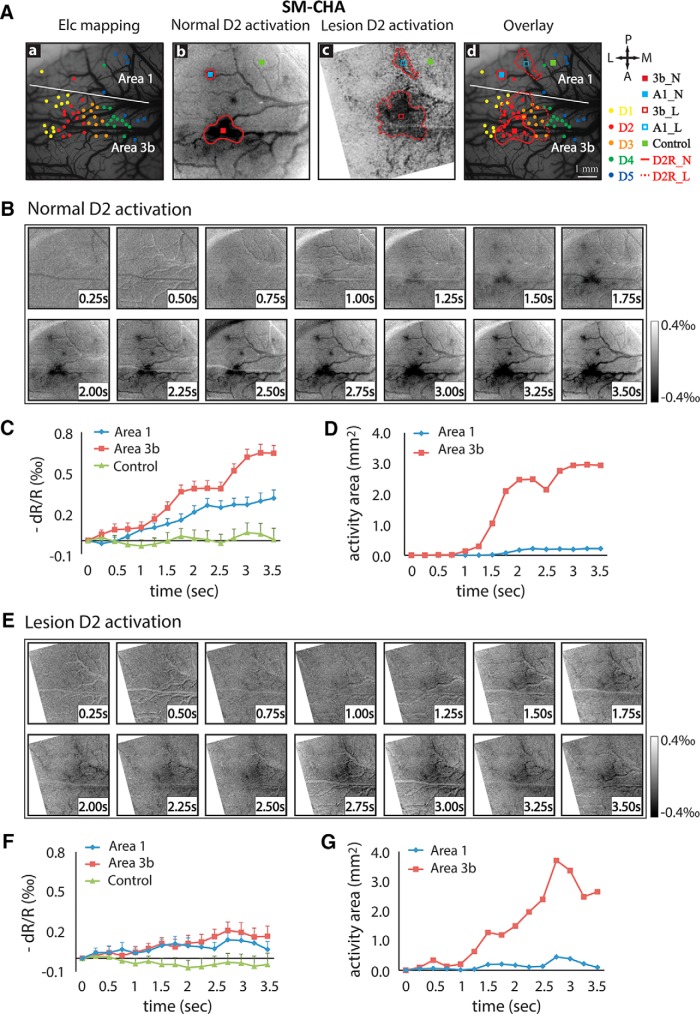
Spatiotemporal dynamics of optical imaging activation in response to single-digit stimulation in somatosensory areas 3b and 1 before and after a DCL in one representative monkey (SM-CHA). Aa–Ad, Postlesion electrophysiological map of digit representation (Aa), D2 mean activation map before DCL (Ab), D2 mean activation map after DCL (Ac), and overlay of Aa, Ab, and Ac (Ad). Electrode penetration sites and properties of the receptive fields are indicated by color dots, and the digit activations are circled by color outlines. Receptive field properties: yellow dots, D1; magenta dots, D2; orange dots, D3; green dots, D4; and blue dots, D5. Full red outlines (D2R_N) and dash red outlines (D2R_L) indicate D2 activation before and after DCL, respectively. Squares show regions for extracting optical signals (see squares in Ab, Ac, and Ad): center of activated area 3b before DCL, red full squares (3b_N); center of activated area 1 before DCL, blue full squares (A1_N); center of activated area 3b after DCL, red dash squares (3b_L); center of activated area 1 after DCL, blue dash squares (A1_L); and one nonactivated control region, green squares. B, First frame-subtracted serial optical images show the development of D2 activations over a 3.5 s vibrotactile stimulation period in areas 3b and 1 before DCL. C, Prelesion time course development of optical signals extracted from area 1 (blue line), area 3b (red line), and a control location (green line). D, Prelesion development of activation sizes in area 1 (blue line) and area 3b (red line) during stimulation. E, First frame-subtracted serial optical images show the development of D2 activations over a 3.5 s stimulation period after DCL. F, Postlesion time course development of optical signals in area 3b (red line), area 1 (blue line), and control (green line). G, Postlesion temporal profile of activation sizes in area 3b (red line) and area 1 (blue line). Error bars indicate the SE.